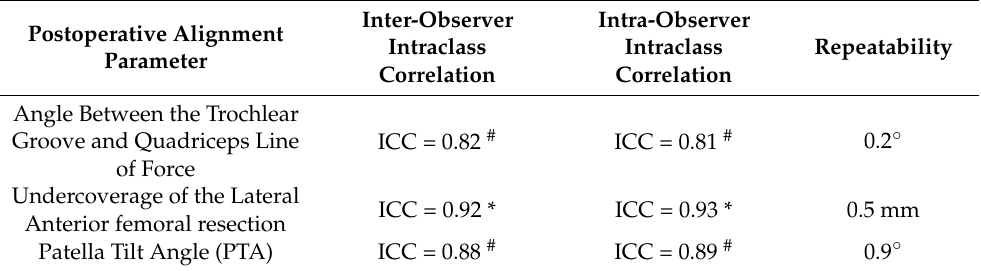
Table 2. Inter-observer and intra-observer intraclass correlation coefficients (ICC values), repeatability, and agreement classification for measurements of the three postoperative alignment parameters.